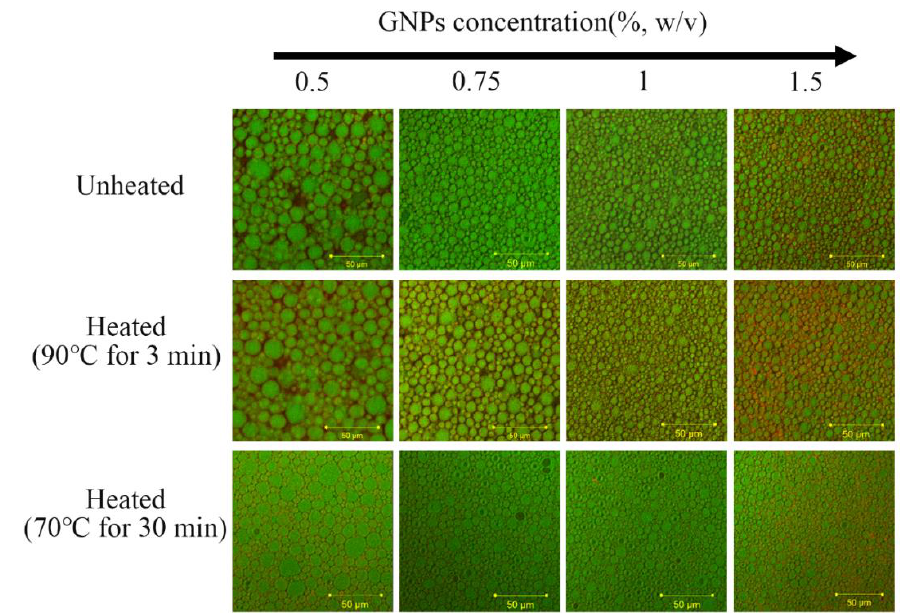
Figure 3. The CLSM images of GNPs Pickering emulgels at room temperature, 90 °C for 3 min and 70 °C for 30 min.